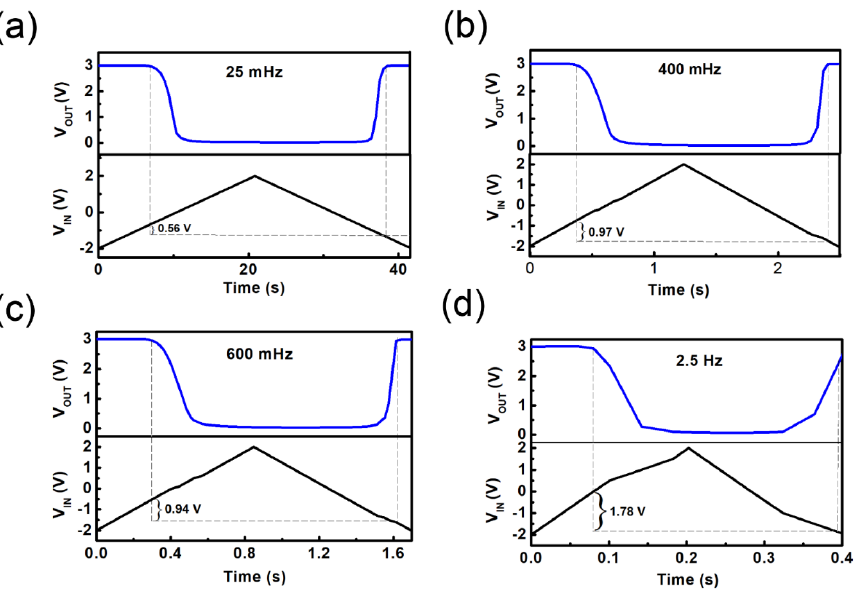
Figure 4. Transient response curve of the Schmitt triggers based on a flexible IWO-based TFT at driving frequencies of ( a ) 25 mHz, ( b ) 400 mHz, ( c ) 600 mHz, ( d ) 2.5 Hz.